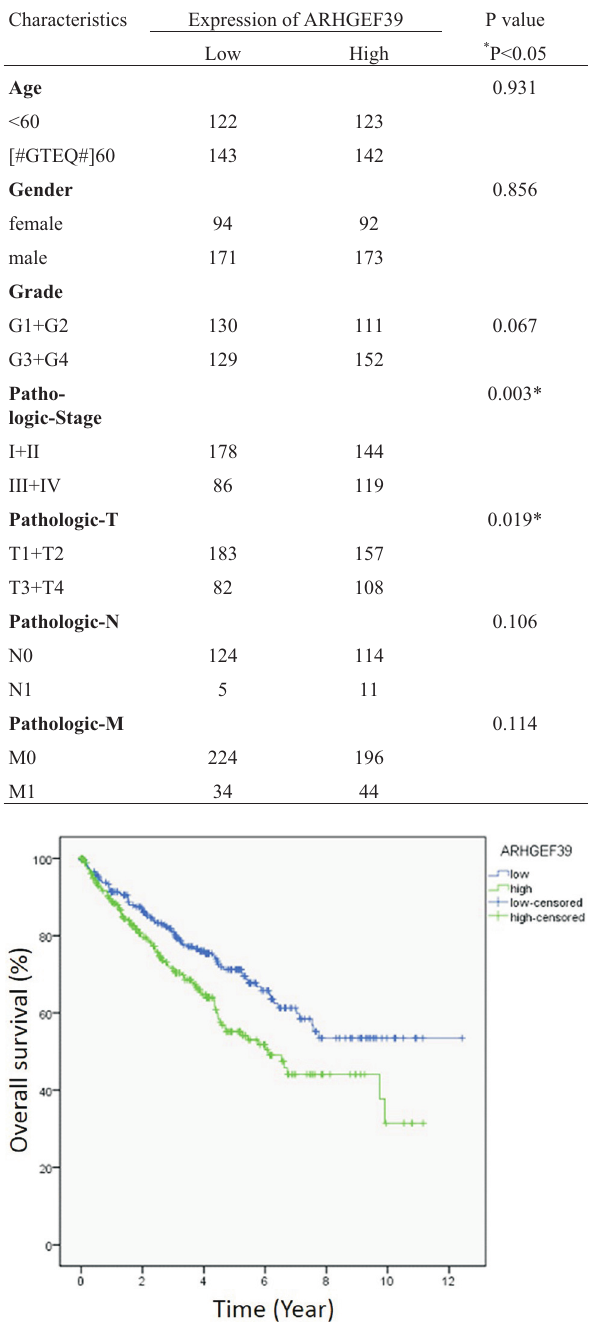
Figure 2 - The survival curves of ARHGEF39 expression and prognosis of ccRCC. The relationship between ARHGEF39 expression and progno- sis was examined by Kaplan-Meier method, and the differences between twogroupswerecomparedbyLog-ranktest.TheccRCCsamplesweredi- vided into high expression group (n=265) and low expression group (n=265) according to the median expression of ARHGEF39. Censored data: incomplete